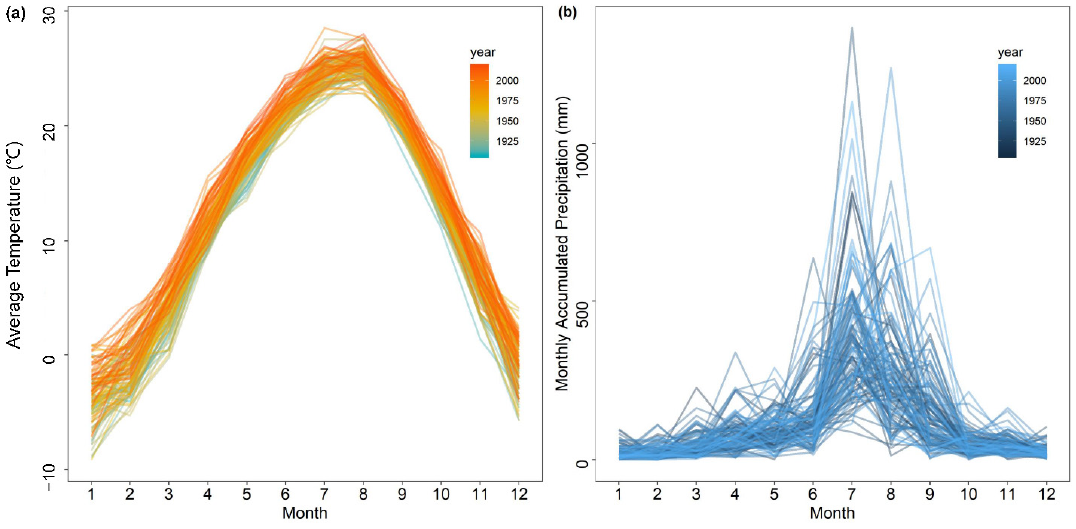
Figure A2. Characteristics of study-site climate from 1907 to 2017. ( a ) Monthly average temperature; ( b ) monthly accumu- lated precipitation.